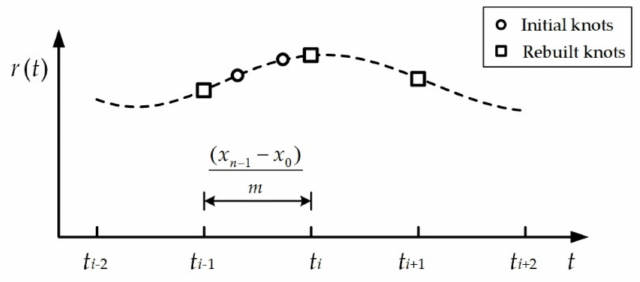
Figure 9. Average for abscissas of newly-built knots.